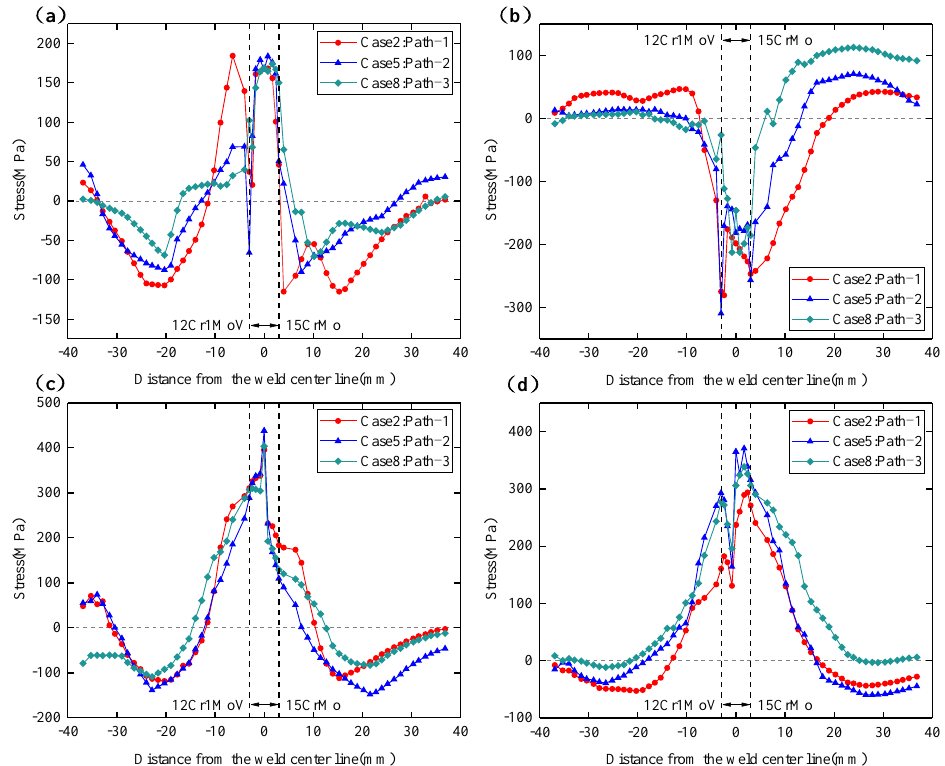
Figure 15. Circumferential and axial residual stress distribution of Case 2, Case 5 and Case 8 at 180° section. ( a ) Circumferential residual stress on the outer surface. ( b ) Axial residual stress on the outer surface. ( c ) Circumferential residual stress on the inner surface. ( d ) Axial residual stress on the inner surface.